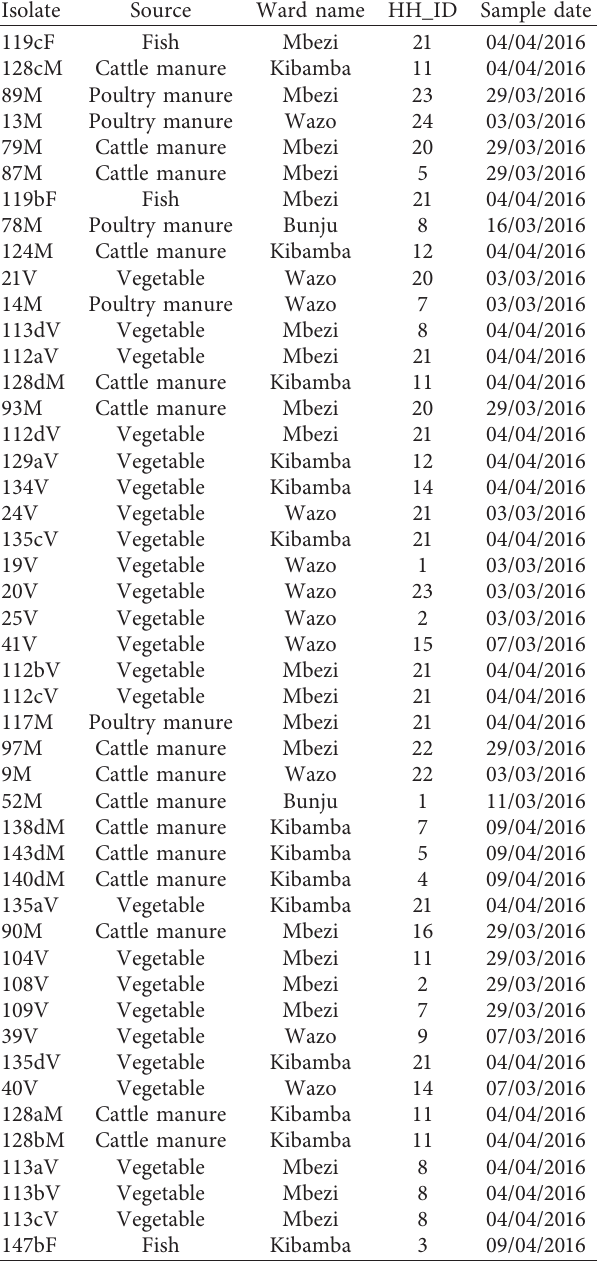
Table 4: Table showing isolate sources including ward, household ID, and date the sample was collected.